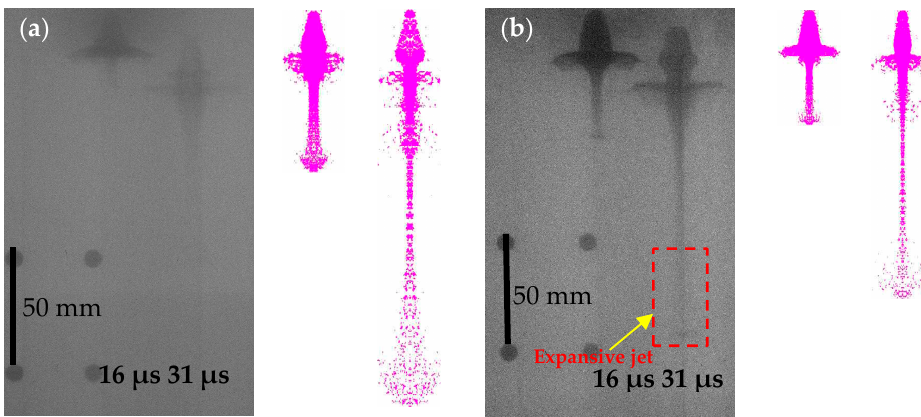
Figure 14. Comparison of X-ray images and numerical simulation results of expansive jet: ( a ) PTFE expansive jet; ( b ) PTFE/Cu-3 expansive jet.